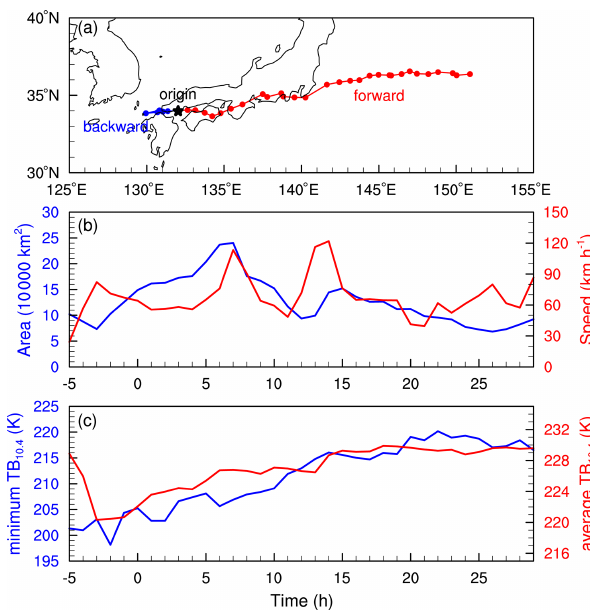
Figure 9. (a) Moving track of the MCS occurring at 13:00UTC on 20 June 2016 and (b) temporal variations in the area, speed, and (c) minimum and average 10.4µm brightness temperature of the